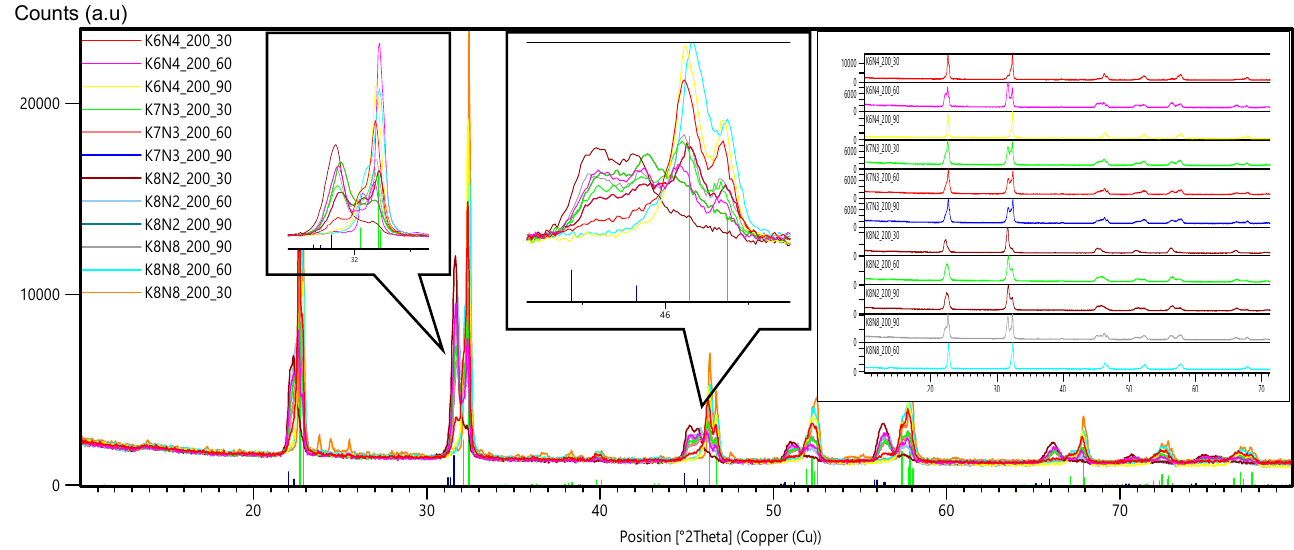
Figure 3. X ‐ ray powder diffraction plot for the samples’ HTMW synthetized at 200 °C, 30–90 min, Figure 3. X-ray powder diffraction plot for the samples’ HTMW synthetized at 200 ◦ C, 30–90 min, compared with orthorhombic NaNbO 3 XRPD pattern (green, PDF 04 ‐ 012 ‐ 8146) and orthorhombic compared with orthorhombic NaNbO 3 XRPD pattern (green, PDF 04-012-8146) and orthorhombic KNbO 3 XRPD pattern (black, PDF 04 ‐ 014 ‐ 4292), graphics displayed successively and overlapped KNbO 3 XRPD pattern (black, PDF 04-014-4292), graphics displayed successively and overlapped plots with upper insert detailed sector 2 θ = 31–33° and 44–46°, respectively. plots with upper insert detailed sector 2 θ = 31–33 ◦ and 44–46 ◦ ,